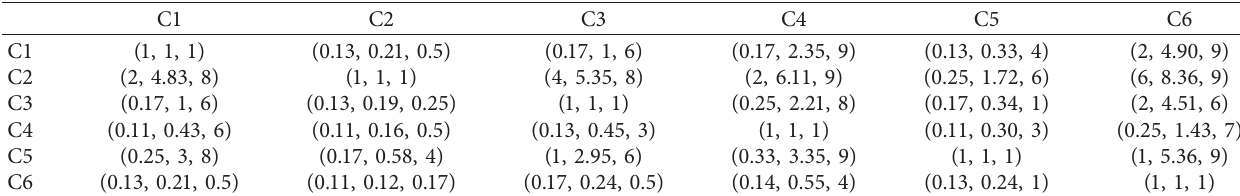
Table 5: FAHP preference comparison matrix.